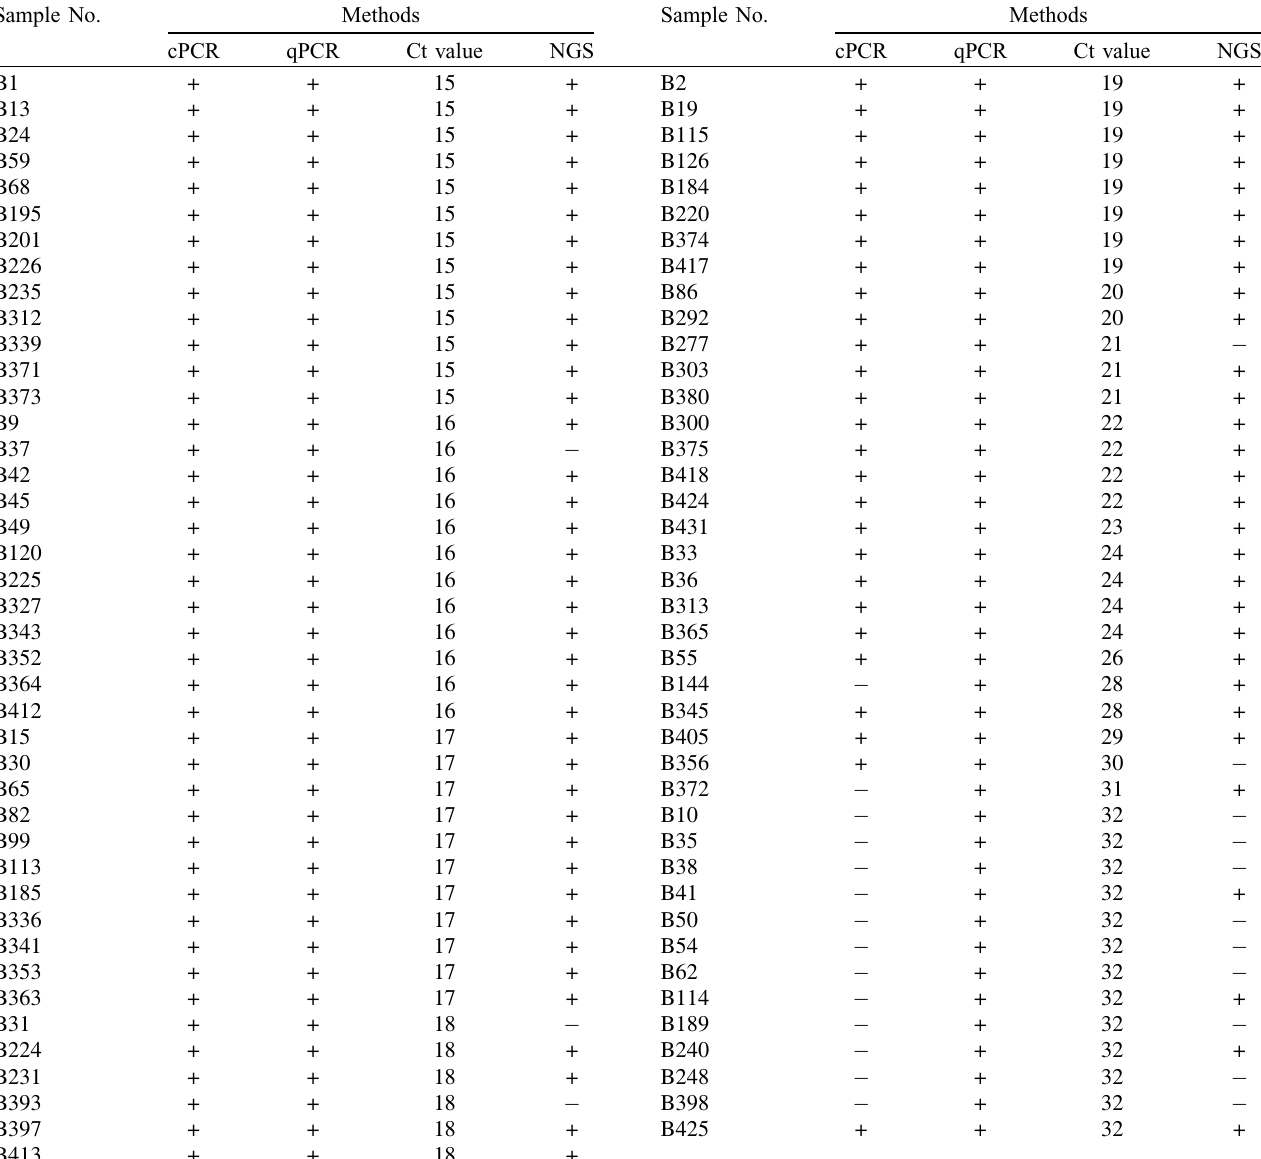
Table 1. Comparison of the sensitivity of conventional PCR (cPCR) and qPCR from the entire dataset of human samples ( n = 288). Evaluation of the success of Blastocystis detection by next-generation sequencing (NGS) only in a set of qPCR-positive samples ( n = 83). Sample No.